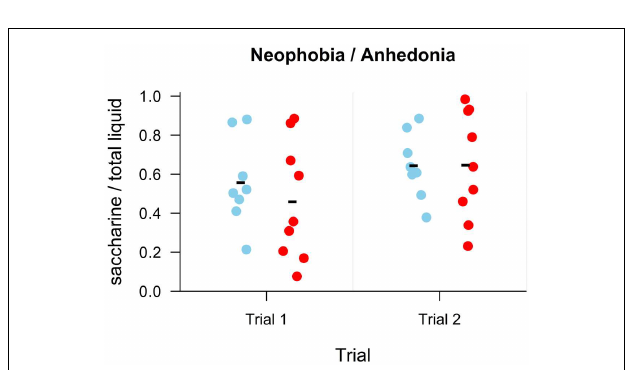
FIGURE 4 | Results of step-through avoidance in seconds . Individual points display values for each subject. Group mean is shown with a minus sign.While no difference is present in the first trial, in the subsequent two trials it took longer for Nogo-A knockdown rats to move into the dark compartment. All subjects with the exception of one remained in the light compartment during the entire test trial, i.e., after obtaining a shock in the dark compartment in the third trial (the three Nogo-A knockdown rats, which did not move into the dark compartment during the third trial were not given the test trial since they did not obtain the shock). Maximum possible duration of the trial was 300s.